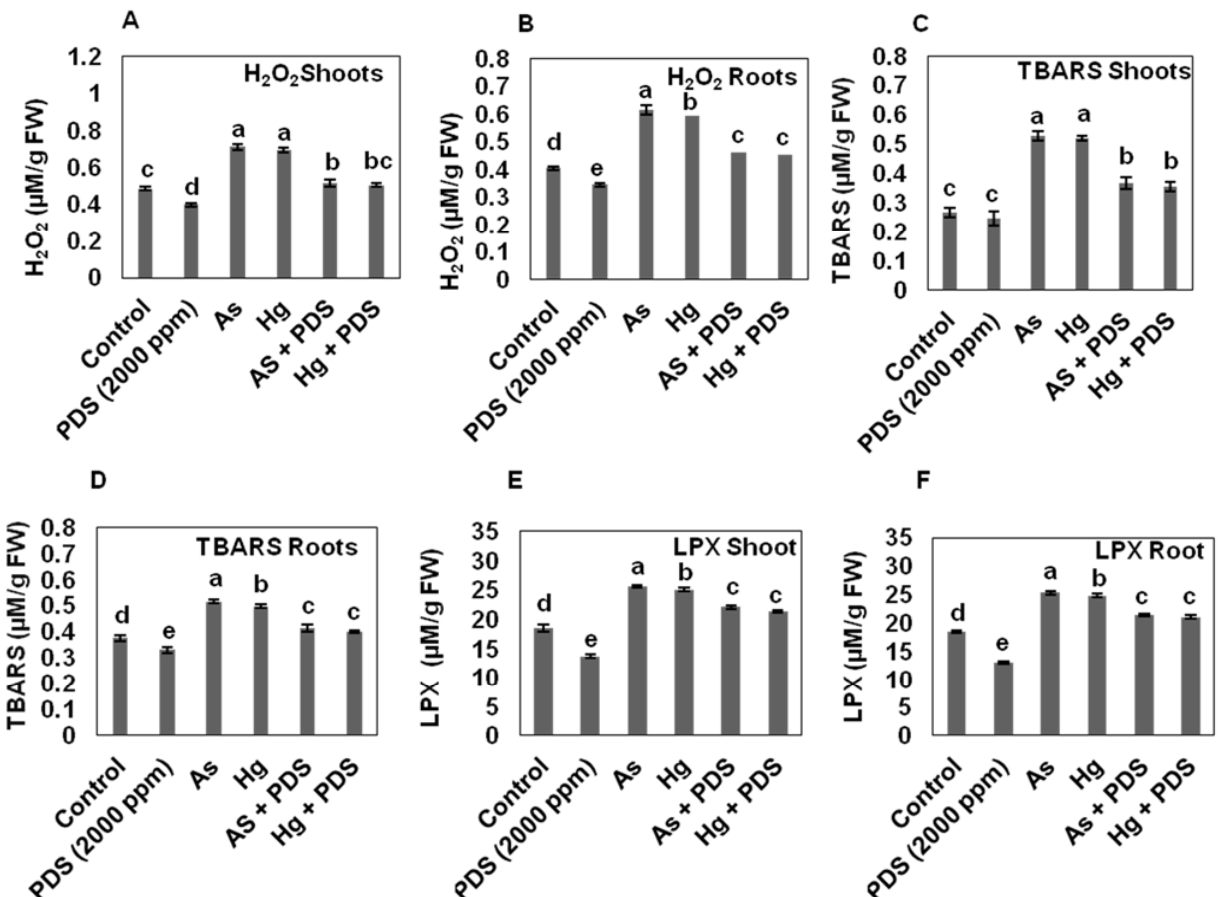
Figure 4. Effect of PDS (2000 ppm) on H 2 O 2 , lipid peroxidation and TBARS under normal, and As/Hg treatment in root ad shoot. The level of H 2 O 2 was determined under control, PDS, As, Hg, As + PDS, and Hg + PDS in shoots and roots ( A , B ). Seven-day-old wheat seedlings were harvested and subjected to the analysis of H 2 O 2 levels. TBARS and lipid peroxidation of 7-day-old seedlings were measured ( C – F ). Five seedlings were randomly collected from each replicate batch. All data were analyzed using one-way ANOVA, with multiple comparisons using the LSD test at a significance level of p ≤ 0.05 ( n = 5). The different lowercase letters represent homogeneous subsets that indicate the statistical significance according to Fisher’s LSD at level p ≤ 0.05.